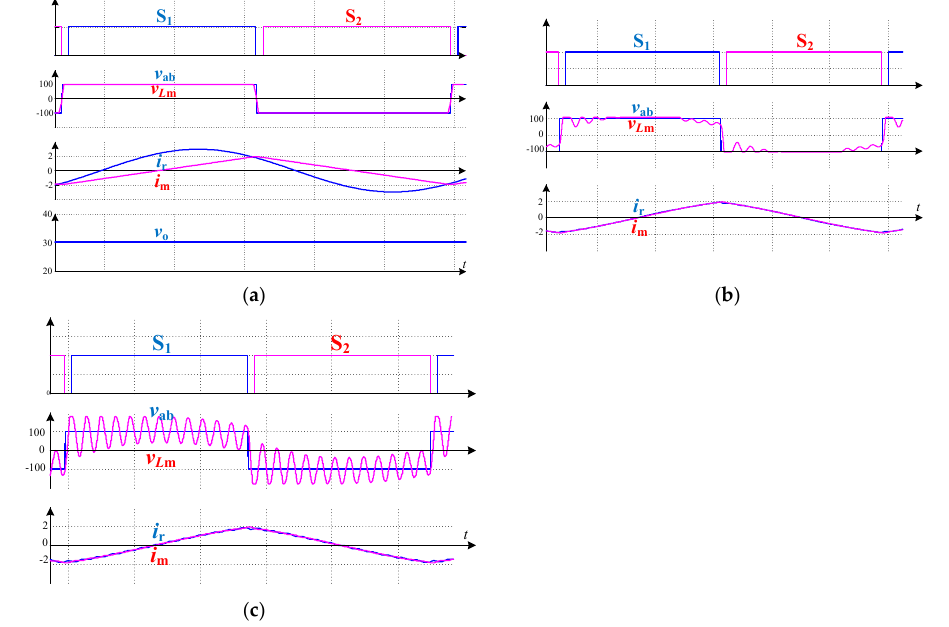
Figure 11. Simulation waveforms under different loads ( f = f r ): ( a ) full load; ( b ) 1% rated load; ( c ) no load.